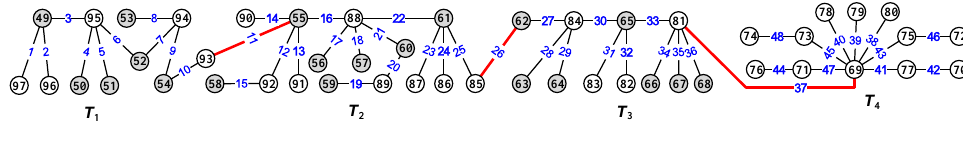
Figure 5. An example for illustrating the proof of Theorem